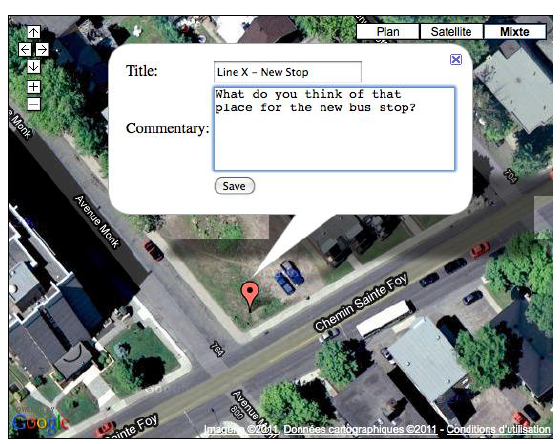
Figure 7. First point is